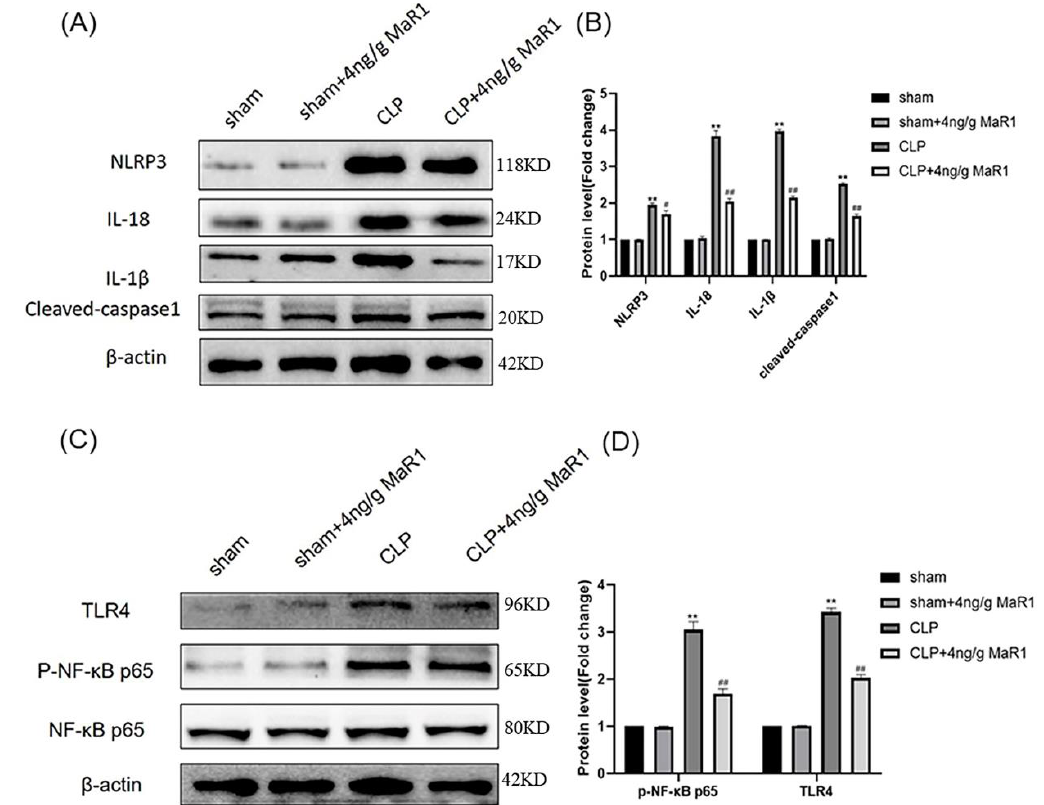
Figure 5. Activation of NLRP3 inflammatory vesicles and dominance of TLR4-NF- κB signaling by 4 ng/g MaR1 on CLP rat hippocampal homogenates: ( A ) medical use of NLRP3, IL-1 β , IL-18, cleaved- caspase1, and β -actin; ( B ) quantitative standards into beta actin NLRP3, cleaved-caspase1, IL-1 β , I-18; ( C ) use for TLR4, p-NF- κ B p65, NF- κ B p65, and β -actin antibody detection of representative immunoblotting; ( D ) quantitative levels of TLR4 and p-NF- κB p65 standardized by β -actin; data are expressed as mean ± SD ( n = 4/group); ** p < 0.01, compared to the Sham group; # p < 0.05, ## p < 0.01, compared to the CLP group.